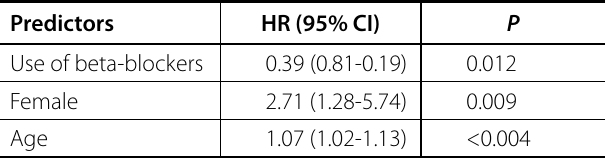
Table 6. Predictors for overall survival in diabetic patients who underwent CABG for stable angina (n=109).